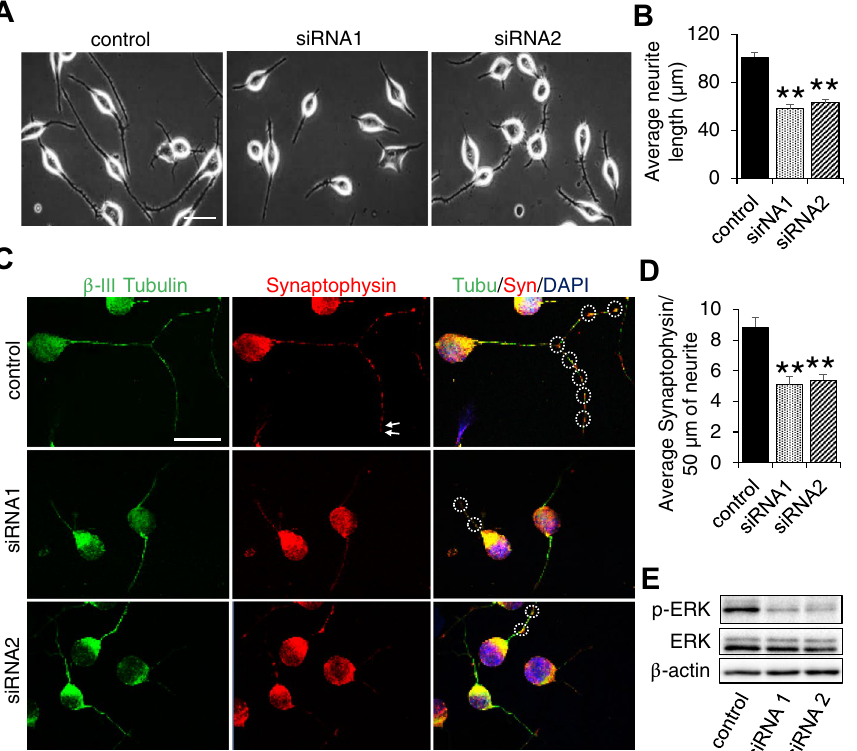
Figure 4. Ndufs4 silencing impairs neurite outgrowth and synaptophysin-positive puncta in differentiated Neuro-2a cell. ( A ) Representative phase contrast image of neurite outgrowth in Ndufs4 silenced differentiated Neuro-2a cells. Scale bar 50 µm. ( B ) ImageJ analysis of average neurite length of differentiated cells (n = 6). ( C ) Representative image of differentiated Neuro-2a cells immunostained for β-III tubulin and synaptophysin. Circles indicate location of synaptophysin in neurites. Scale bar 40 µm ( D ) ImageJ analysis of average number of synaptophysin in neurites/50 µm (n = 6). ( E ) Representative image of Western blot for the pERK and ERK in control and Ndufs4 silenced differentiated Neuro-2a